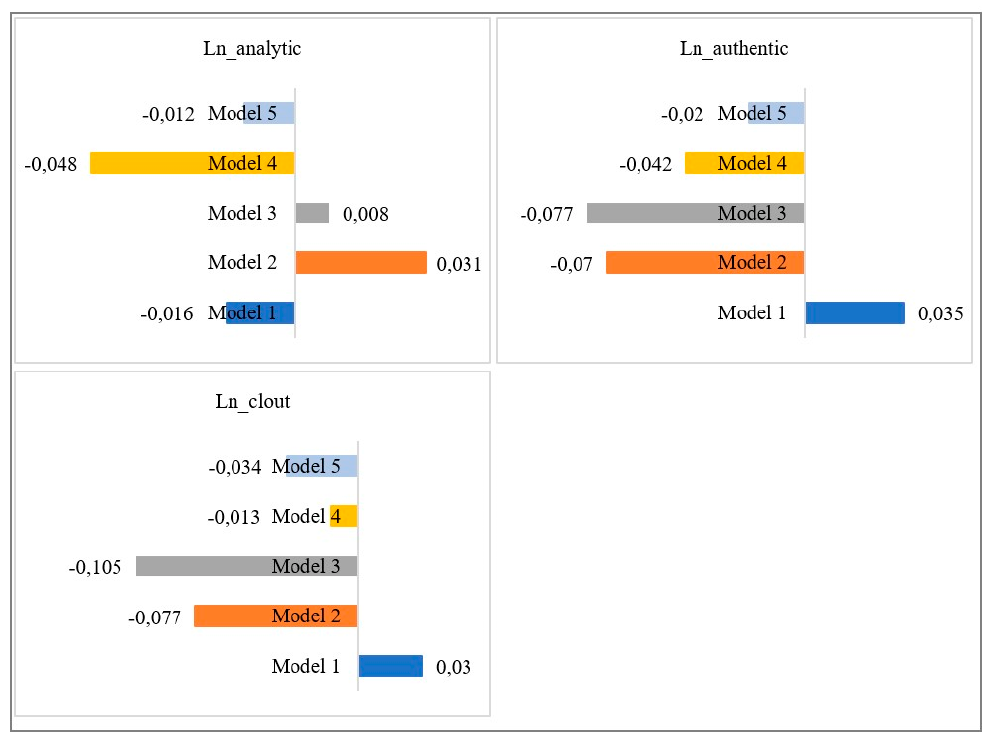
Figure 4 . Review textual variables' coefficients in system GMM models . Figure 4. Textual product variables coefficients in system GMM